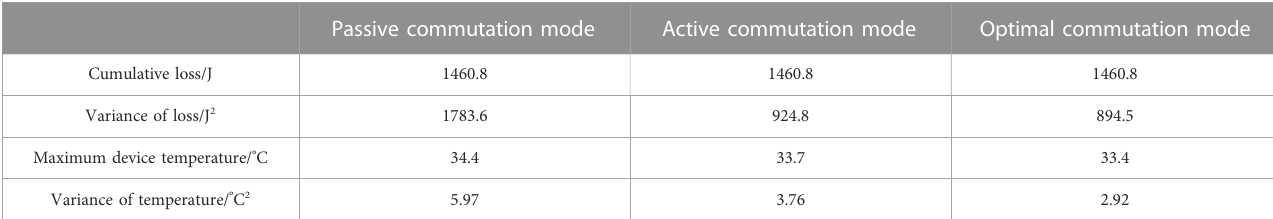
TABLE 4 Loss and temperature comparison of different commutation